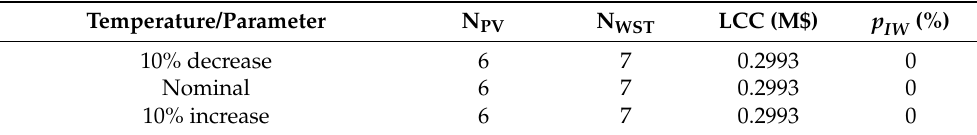
Table 14. Effect of temperature changes on system optimization.